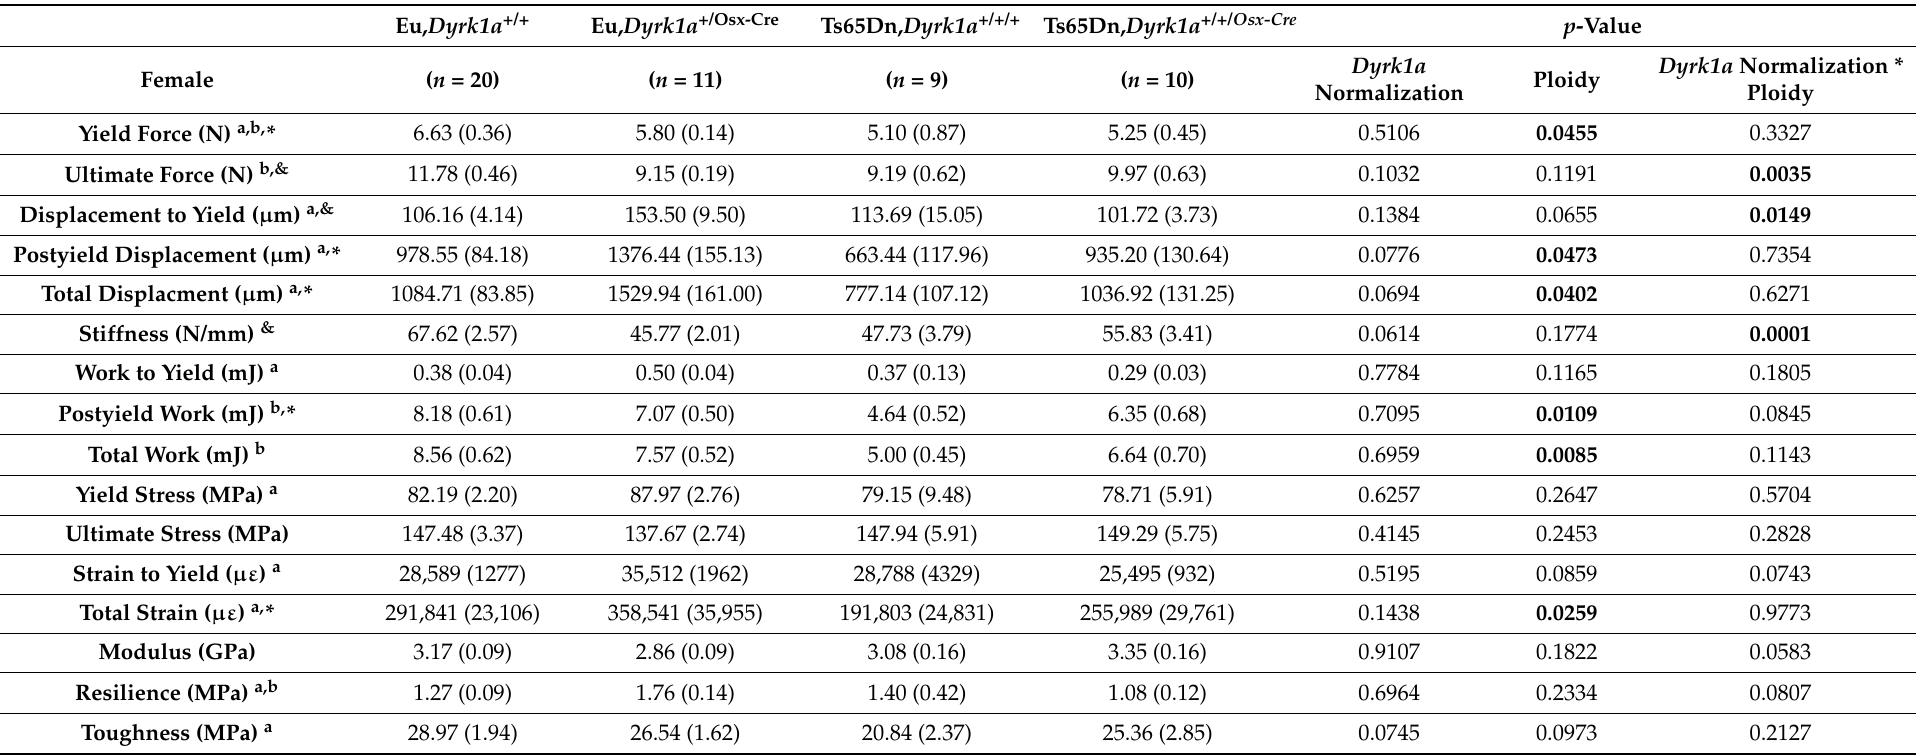
Table 1. Mechanical testing for 6-week-old female euploid and trisomic Ts65Dn